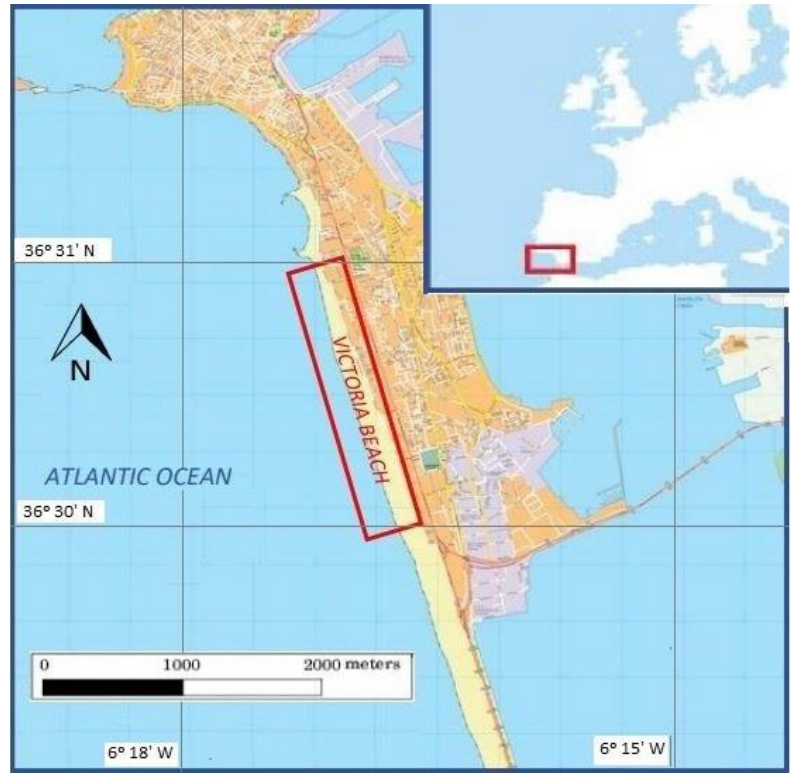
Figure 1. Location of Victoria Beach, the study area where the methodology was applied.